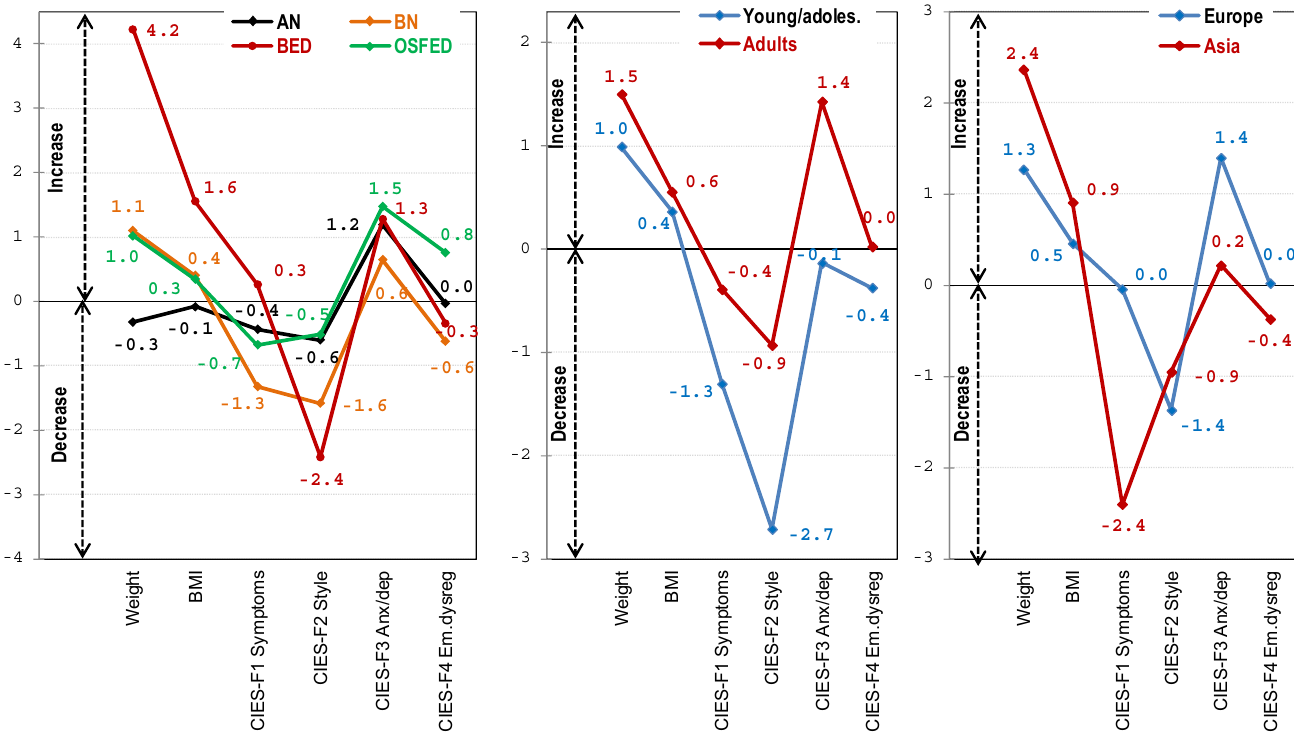
Figure 1. Differences (post-pre changes) for the weight, the BMI and the CIES factors.